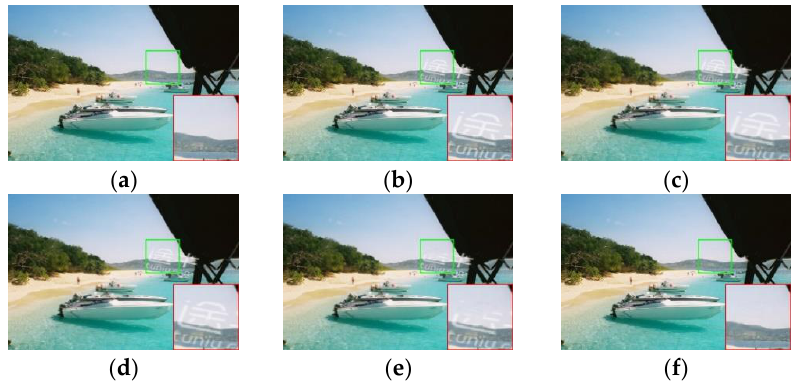
Figure 3. Visual effects of different methods with a transparency rate of 0.5 for image watermark removal. ( a ) Original image, ( b ) watermark image, ( c ) DnCNN, ( d ) FFDNet, ( e ) U-net and ( f ) IWRU-net (ours).